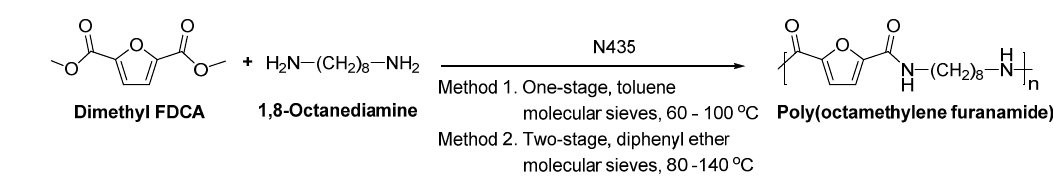
Polymers 2016 , 8 , 243 37 of 52 Scheme 53. N435-catalyzed polymerizations with furan monomers: bis(hydroxymethyl)furan (BHMF), 5-hydroxymethyl-2-furancarboxylic acid (HMFA) and dimethyl 2,5-Furandicarboxylic acid (FDCA) [306,307].